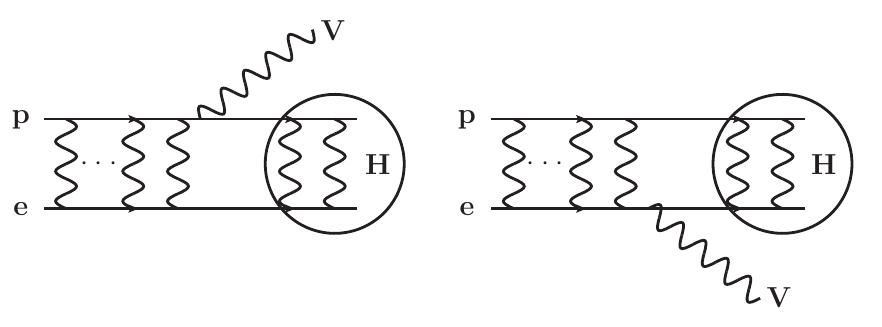
Figure 1: The process targeted in this project. A dark proton and dark electron combine to form dark hydrogen through the emission of a massive mediator (dark photon). The mediator decays into SM particles through its kinetic mixing with hy- percharge, which eventually yields lower energy photons, which can be searched for by